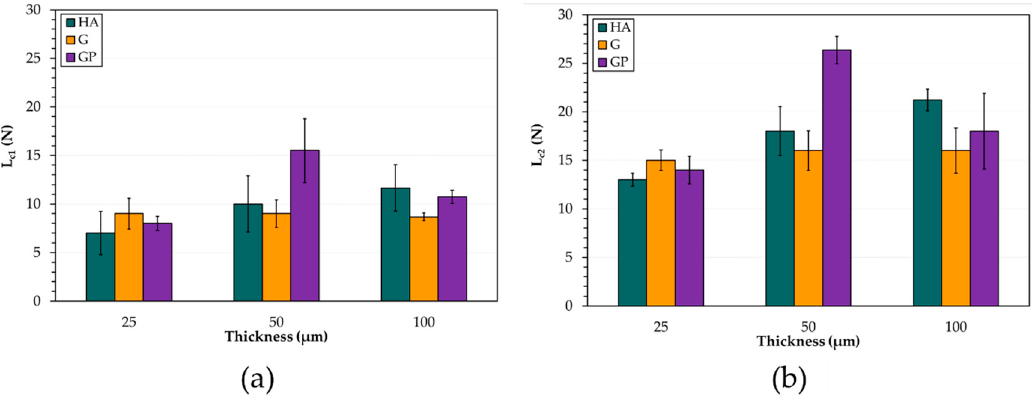
Figure 6. Mean values ± standard deviations of the critical loads ( a ) L c1 and ( b ) L c2 for all anodizing treatments and thicknesses of anodic aluminum oxides.